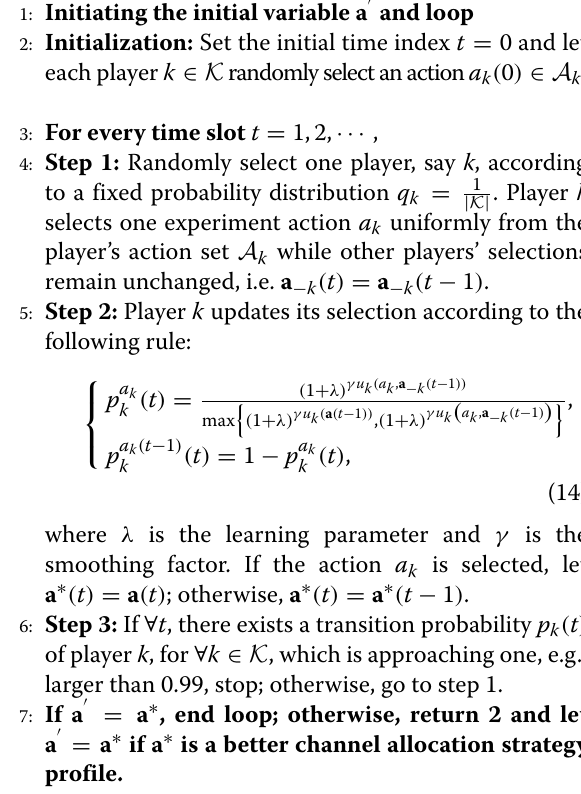
Algorithm 1 Distributed channel allocation